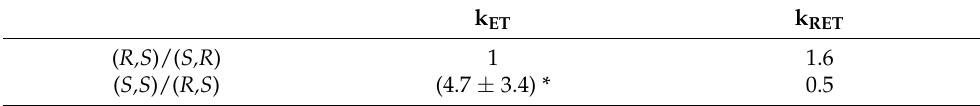
Table 4. The ratios of k ET and k RET in enantiomers and diastereomers of